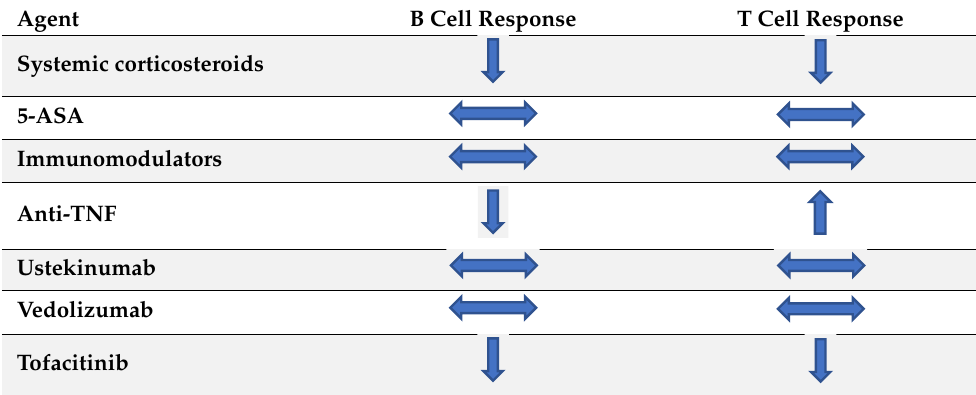
Arrows represent risk compared to the general population.